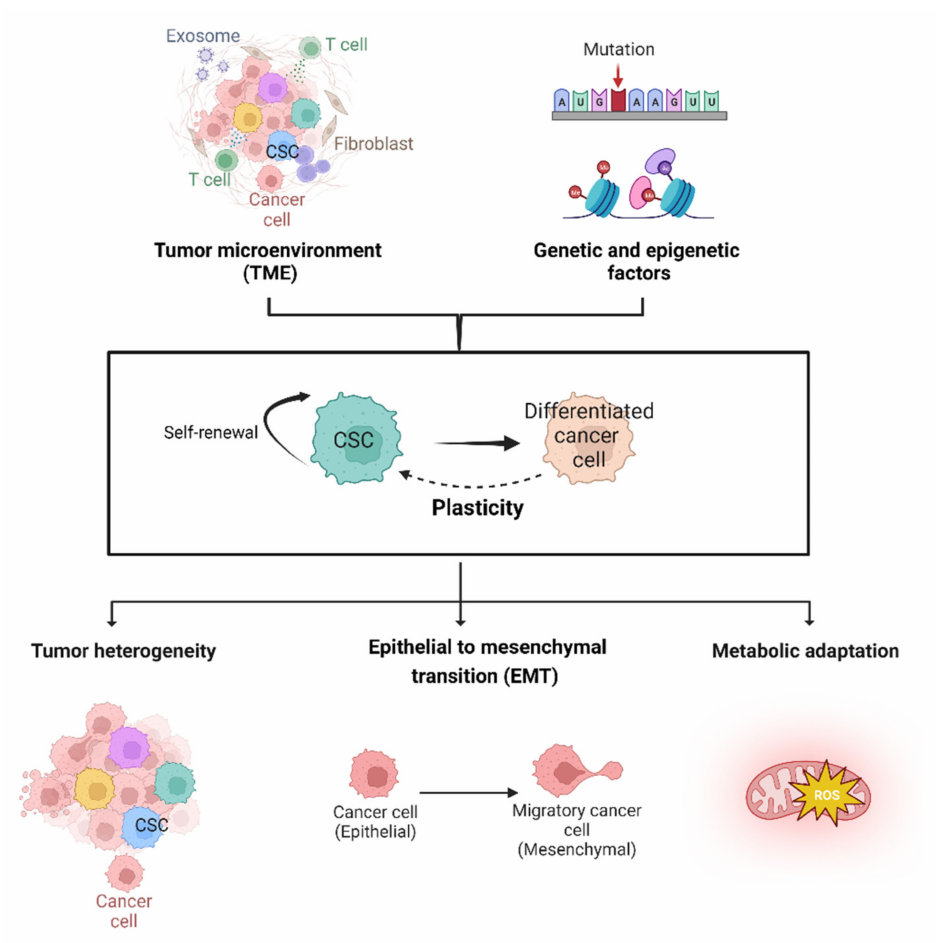
Figure 1. Mechanisms involved in brain CSCs’ plasticity model. CSCs plasticity is the capacity to shift dynamically and reversibly from dedifferentiated to a differentiated state. Brain CSCs plasticity depends on both tumor microenvironment factors (i.e., metabolites, cytokines, growth factors, exosomes) and genetic/epigenetics modifications. The main consequence of cell plasticity is the formation of highly heterogeneous tumor mass, characterized by the activation of EMT and metabolic adaption programs. Created with